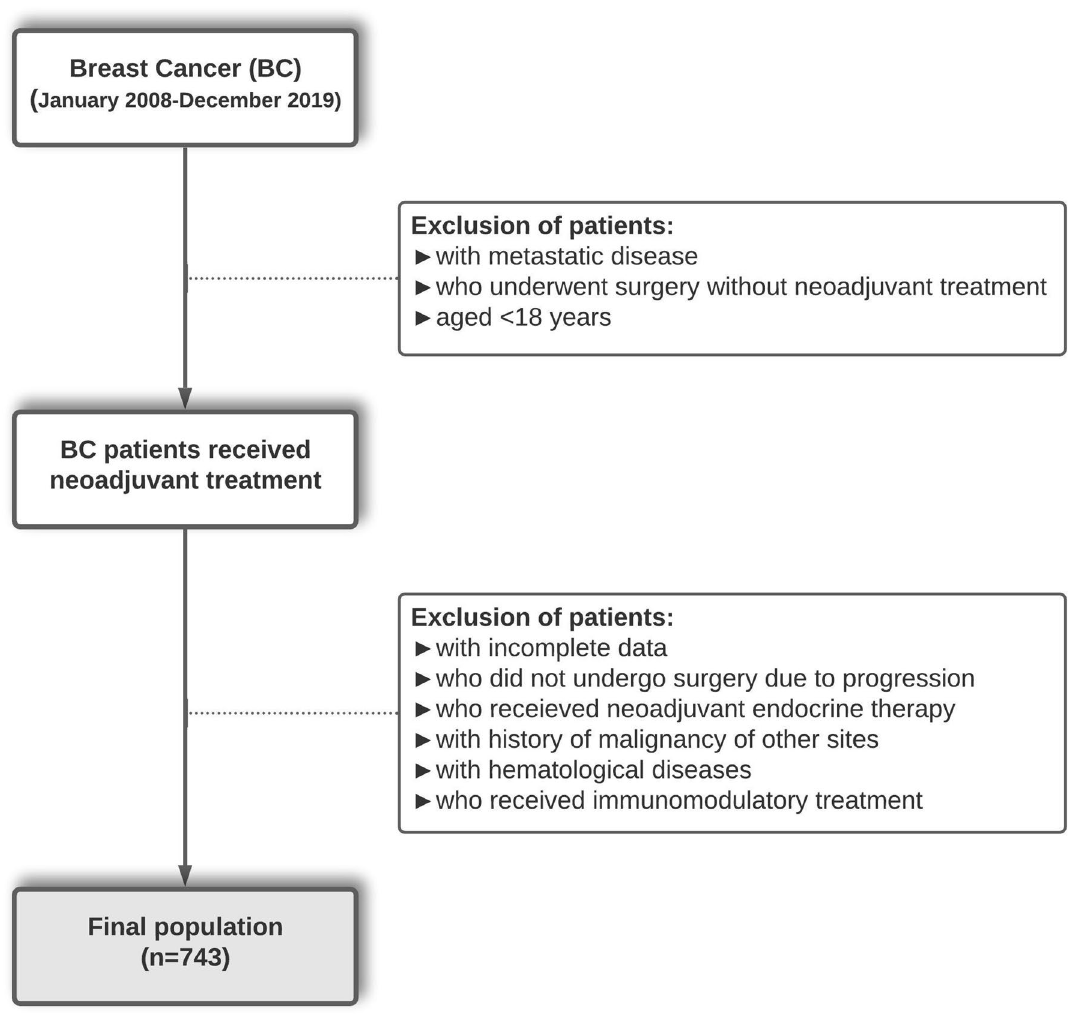
Figure 2. Flowchart of patients